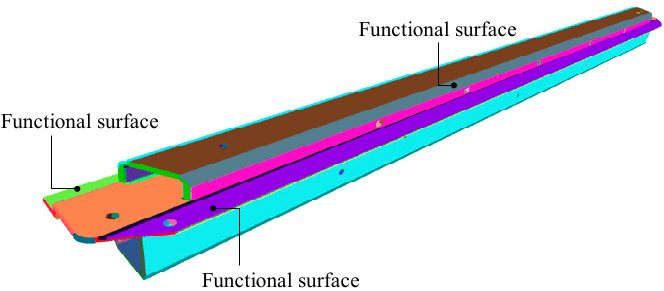
Figure 4. The division of functional surface in a certain STEP file.